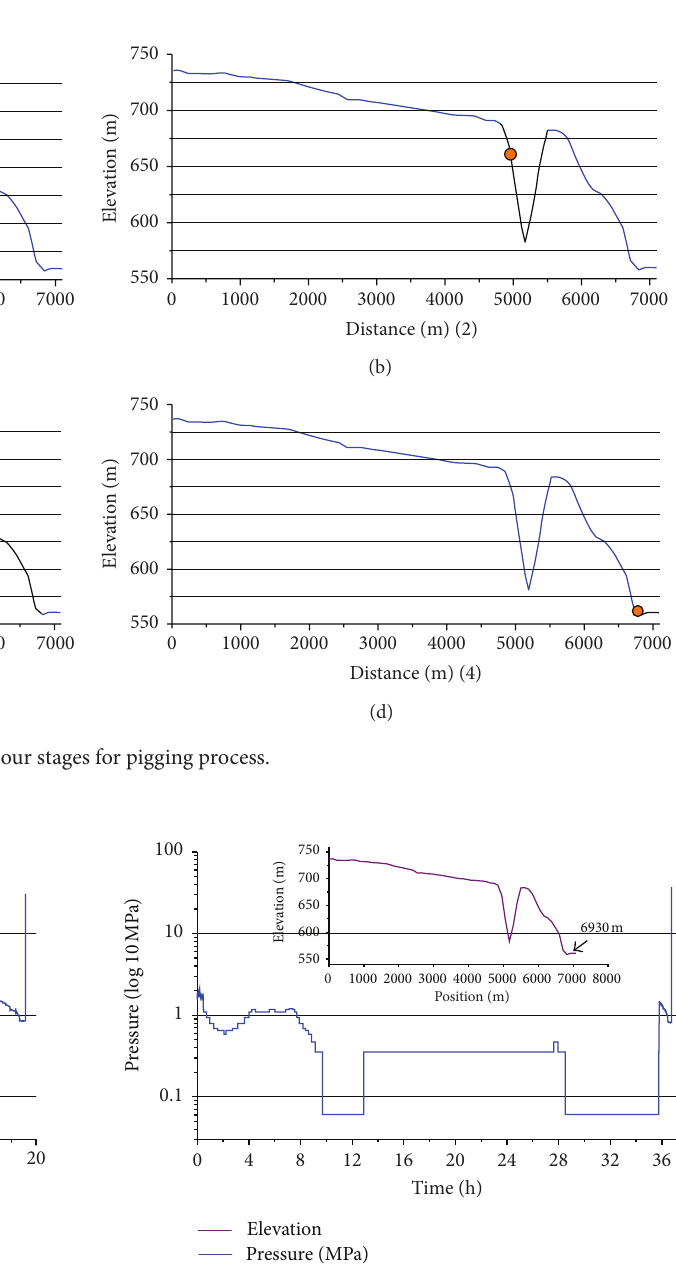
Figure 6: Numerical result of pressure at the end of pipe for the second accident.